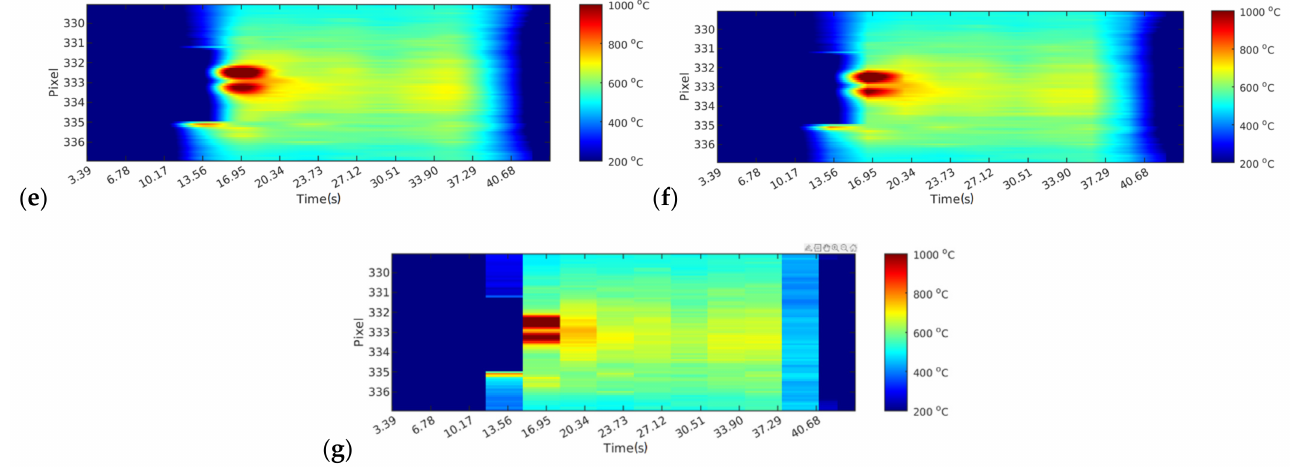
Figure 12. Temporal joint reconstruction for R1 bottom edge profile of S13: ( a ) original IR sequence and interpolated se- quences; ( b ) cubic interpolation, 24; ( c ) linear interpolation, 24; ( d ) nearest neighbor interpolation, 24; ( e ) cubic interpolation, 192; ( f ) linear interpolation, 192; and ( g ) nearest neighbor interpolation, 192.